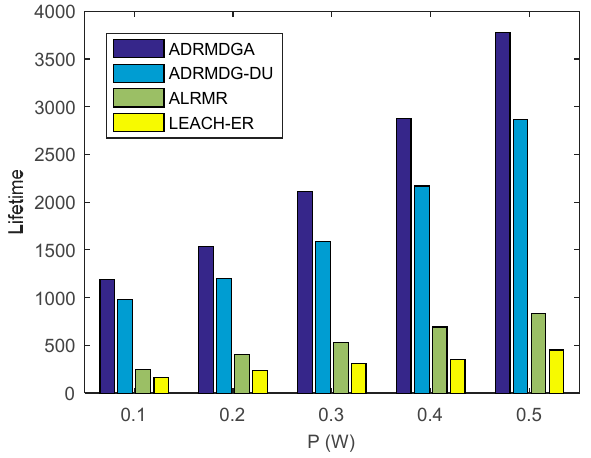
Figure 8. Impact of charging power on network lifetime in different algorithms ( N = 100).